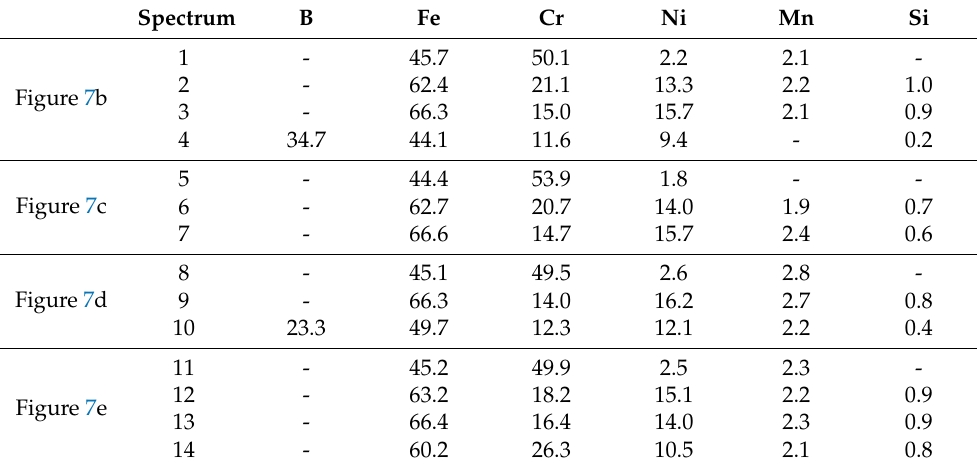
Table 3. Elements content of EDS point scan analysis of BSSs after hot compression test